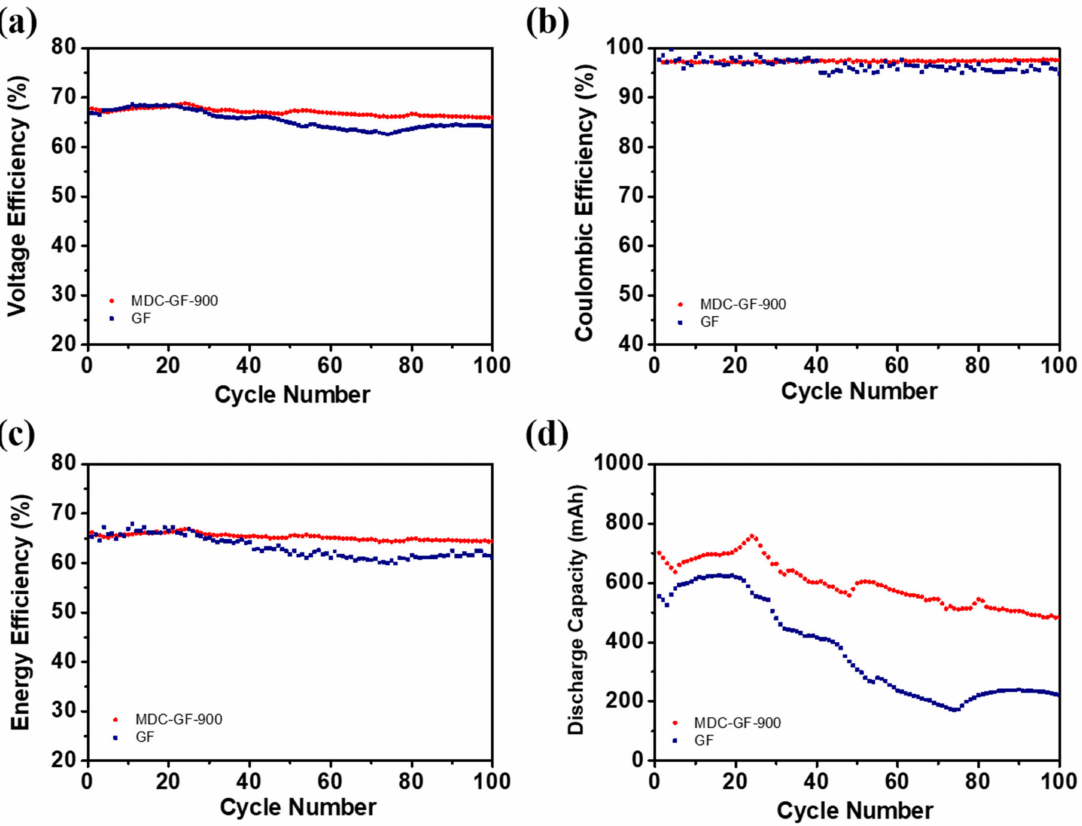
Figure 9. ( a ) VE, ( b ) CV, ( c ) EE, and ( d ) discharge capacity of 100 charge-discharge cycles for the cell with MDC-GF-900 and GF at a current density of 100 mA cm − 2